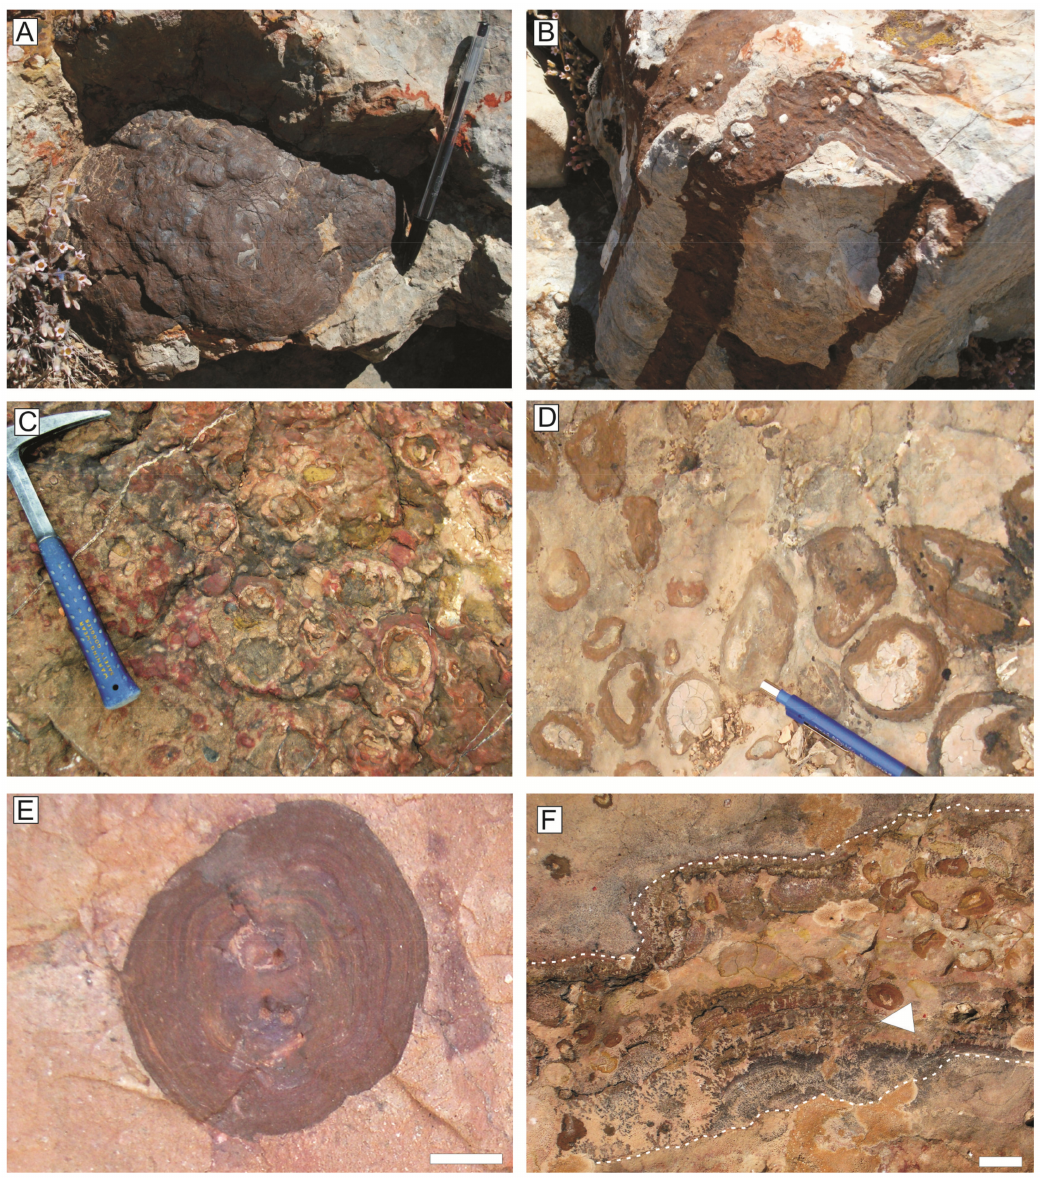
Figure 4. Field view of the iron crusts and macro-oncoids. Central External Subbetic: ( A ) Iron surficial crust on the Bathonian hardground of the Navahermosa outcrop. ( B ) Iron endostromatolite growth in a paleokarstic structure (paleokarren surface) of the Navahermosa outcrop. Eastern External Subbetic: ( C ) Bathonian hardground with iron crusts from the L ú gar outcrop. ( D ) Ammonoids from the Callovian-Oxfordian hardground with iron coating forming irregular macro-oncoids at the Qu í par outcrop. ( E ) Iron macro-oncoid from the Bathonian hardground of the Rambla Honda outcrop. ( F ) Feature of a neptunian-dyke with iron endostromatolites in the walls (arrow) in the Bathonian hardground of the Rambla Honda outcrop. Note: scale-bar = 1